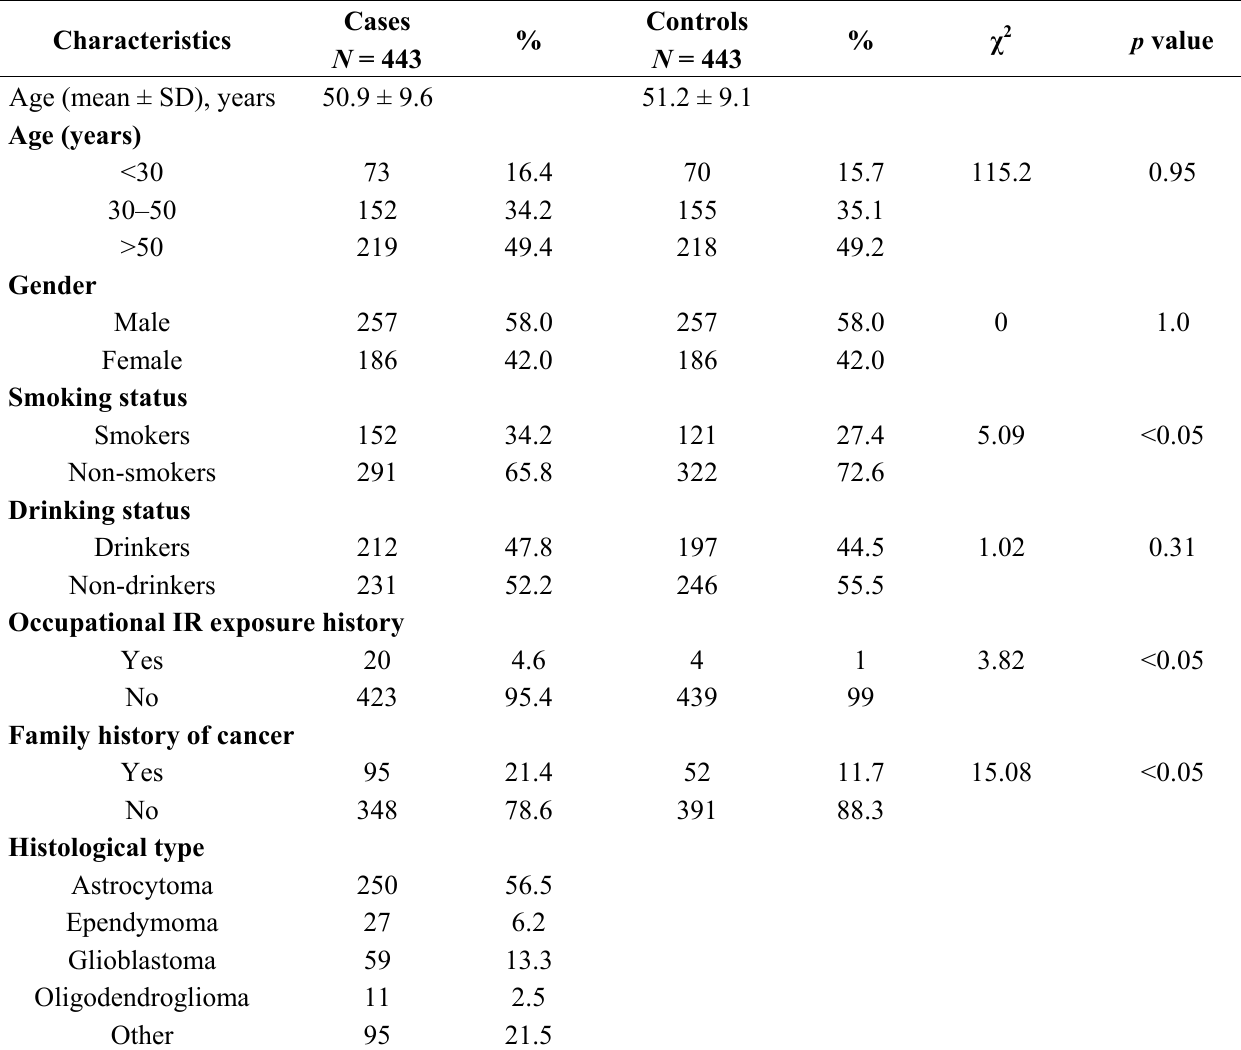
Table 1. Characteristics of glioma cases and